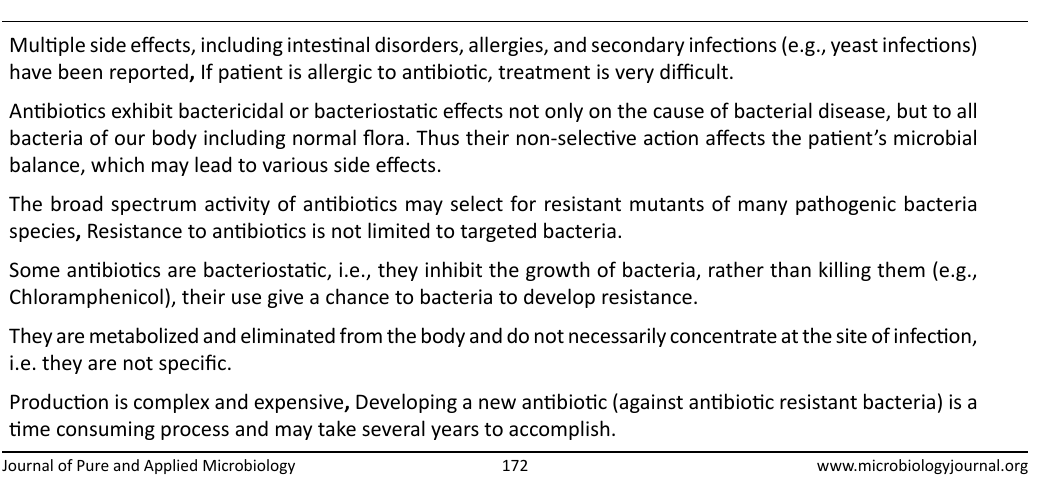
table 1. Main disadvantages of broad spectrum antibiotics Conventional